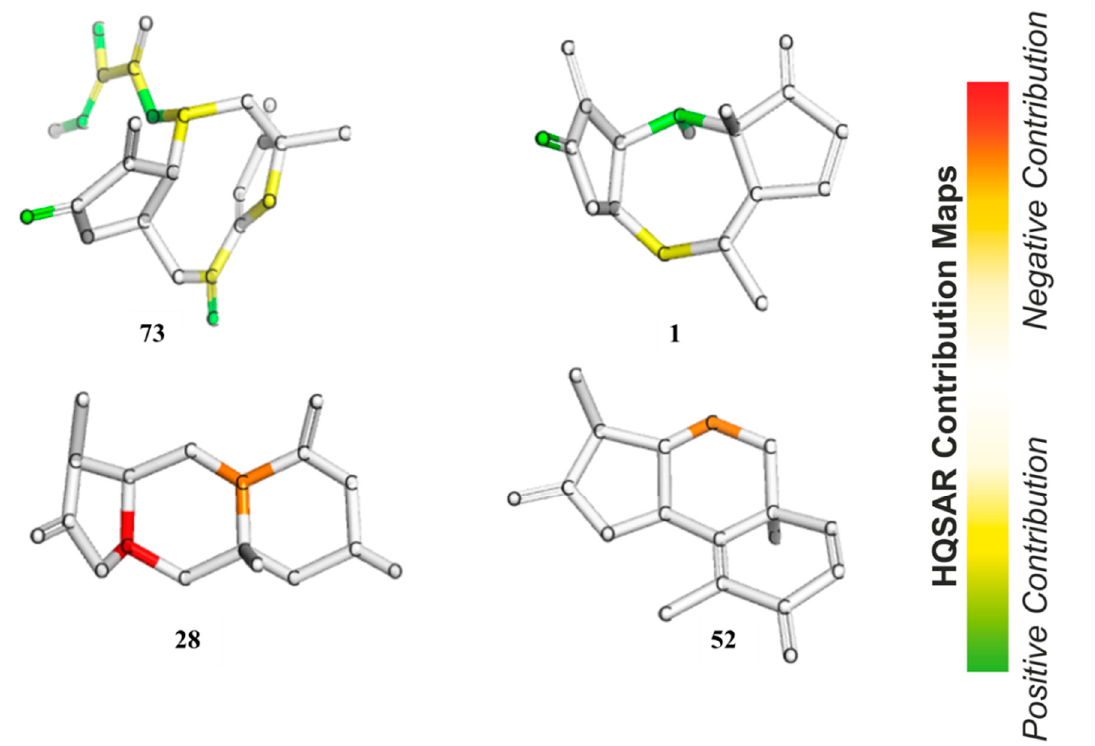
Figure 8. HQSAR maps of positive and negative contribution of the most active ( 73 , 1 ) and least active ( 28 , 52 ) compounds for the HQSAR model with A/C/Ch fragment distinction (Model 8).